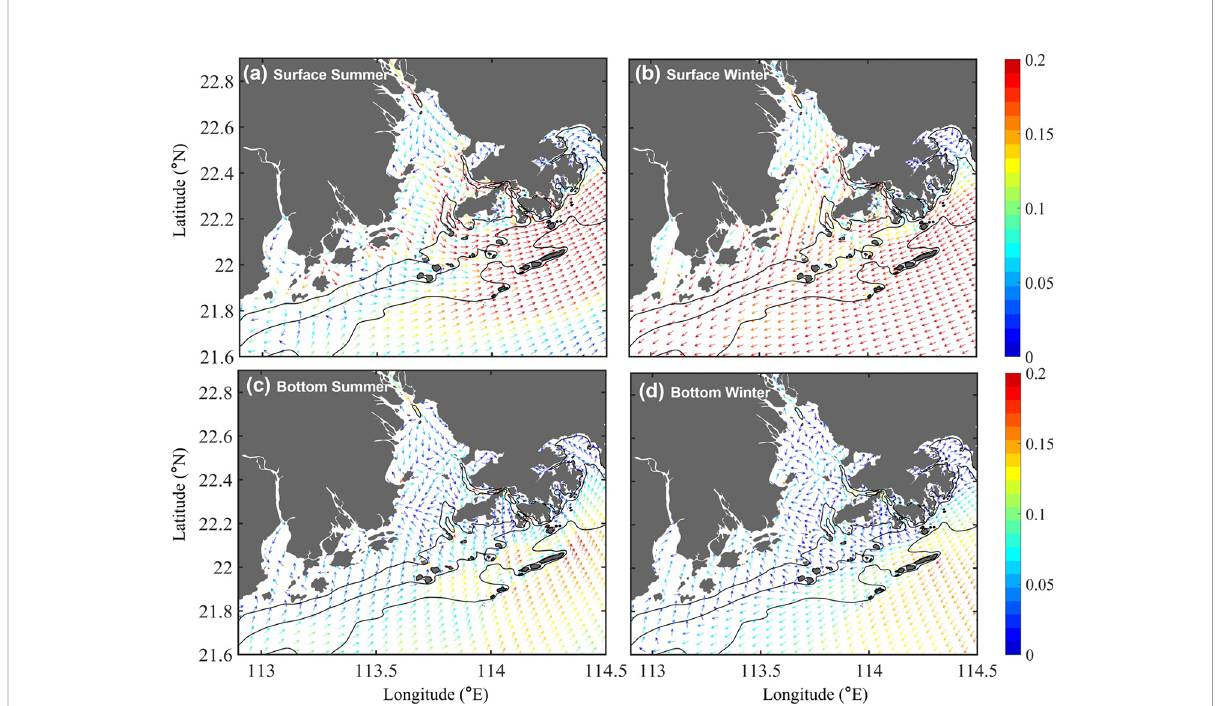
FIGURE 2 (A, C) Horizontal map of the seasonally averaged surface and bottom currents in summer calculated by the numerical model in this study; the arrow and color represent the direction and magnitude (m/s) of the velocity, respectively. (B, D) Same as (A, C) , except that they represent winter conditions. The black lines are 10 – 30 m